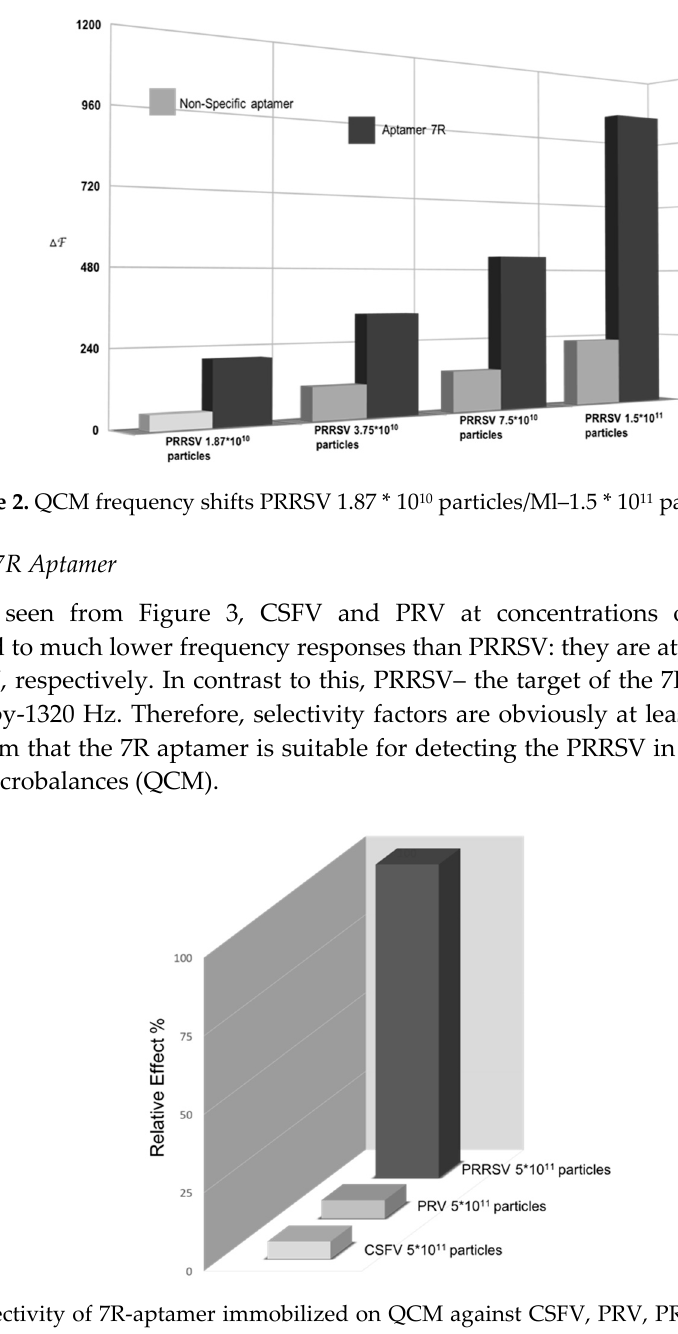
Figure 3. Selectivity of 7R-aptamer immobilized on QCM against CSFV, PRV, PRRSV, respectively, at 1.87 * 10 10 particles/mL—1.5 * 10 11 particles/mL. The PRRSV signal is used as the reference standard